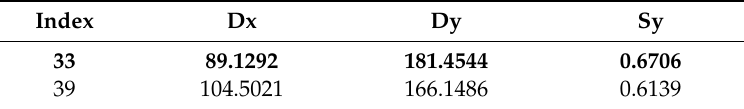
Table 7. Results from TOPSIS analysis for index 33 and